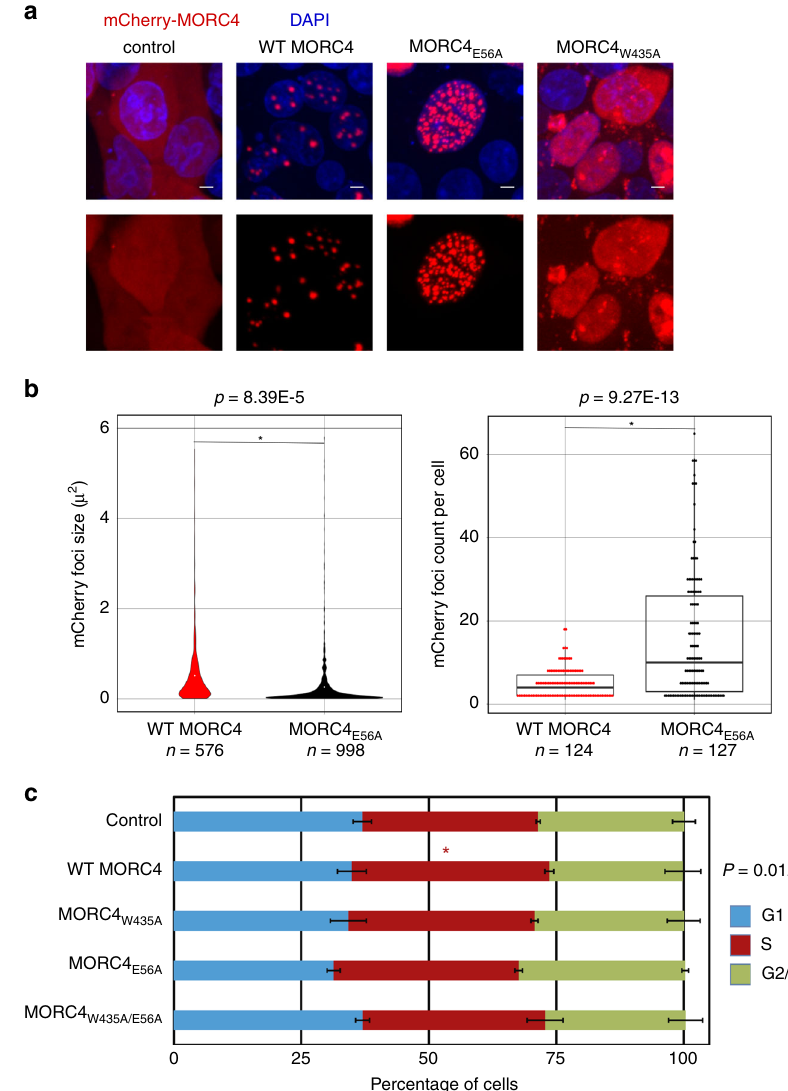
Fig. 7 MORC4 forms NBs and affects the S phase cell cycle. a Representative confocal microscopy images of 293T-HEK cells overexpressing mCherry- CTRL, mCherry-MORC4 WT, mCherry-MORC4 E56A or mCherry-MORC4 W435A. Transfection were performed a minimum of three times, scale bars represent 5 μ m. b MORC4 E56A shows a signi fi cant decrease in mCherry foci size ( p = 8.39E − 5) and a signi fi cant increase in number of mCherry foci per cell ( p = 9.27E − 13) compared to MORC4 WT. The analysis shown is from at least 10 independent images (WT MORC4 n = 13, MORC4 E56A n = 15), with a minimum of 120 nuclei analyzed for each condition (WT MORC4 n = 124, MORC4 E56A n = 127). c Cell cycle analysis following 48-h overexpression of MORC4 proteins exhibit increased percent of cells in S phase for WT MORC4 ( p = 0.012) compared to control cells. Data represent the average of three independent experiments. Error bars represent S.E.M., * indicates signi fi cant difference from mCherry-CTRL ( p < 0.05) by two-tailed student t